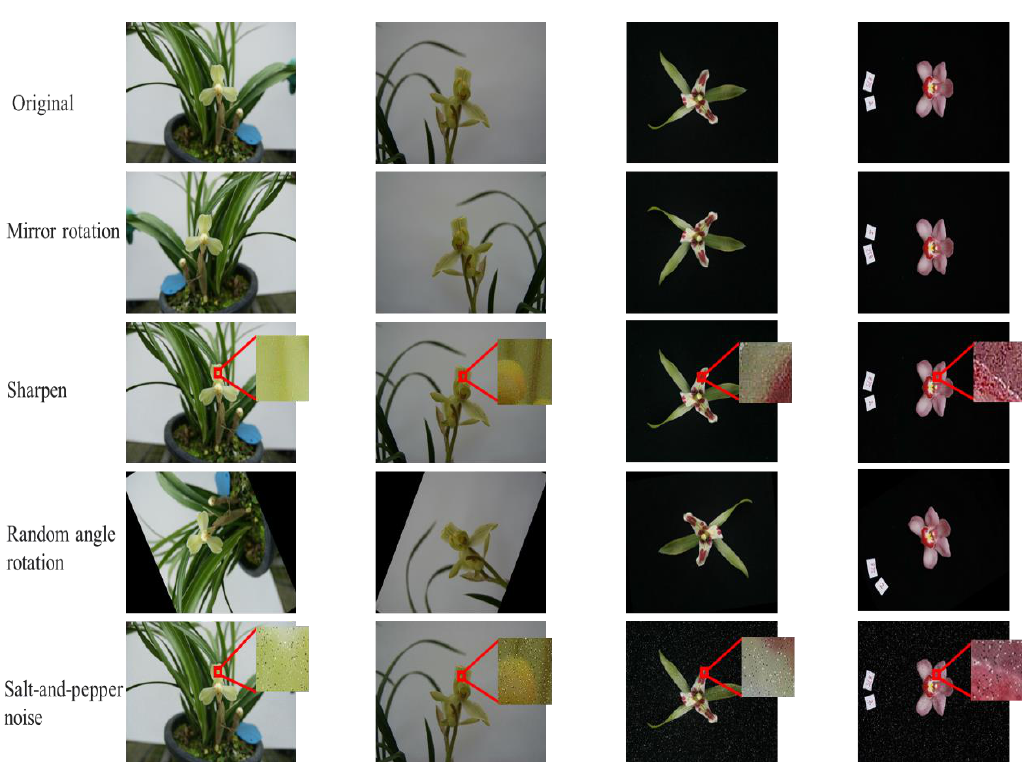
Figure 3. Examples of the effects before and after image